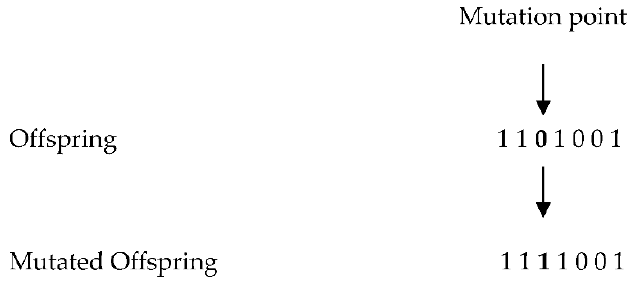
Figure A2. The scheme of a single mutation process.